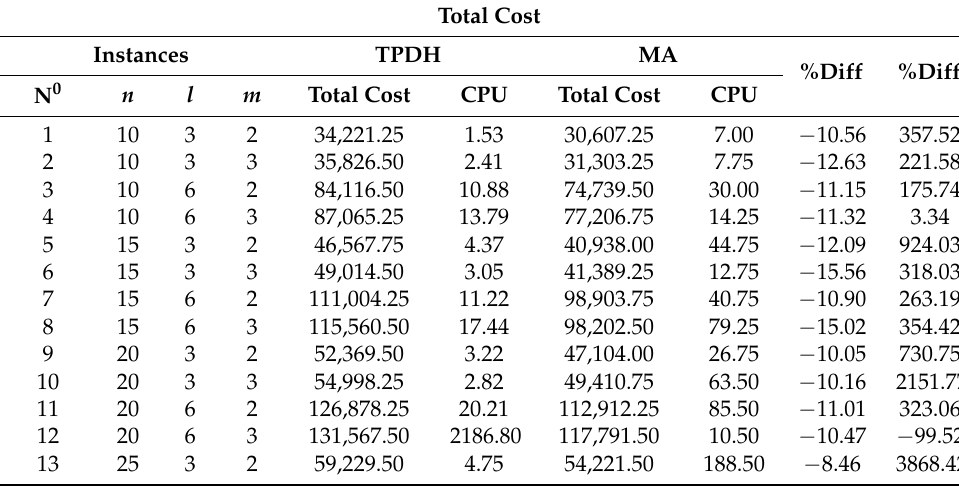
Table 21. Overall cost